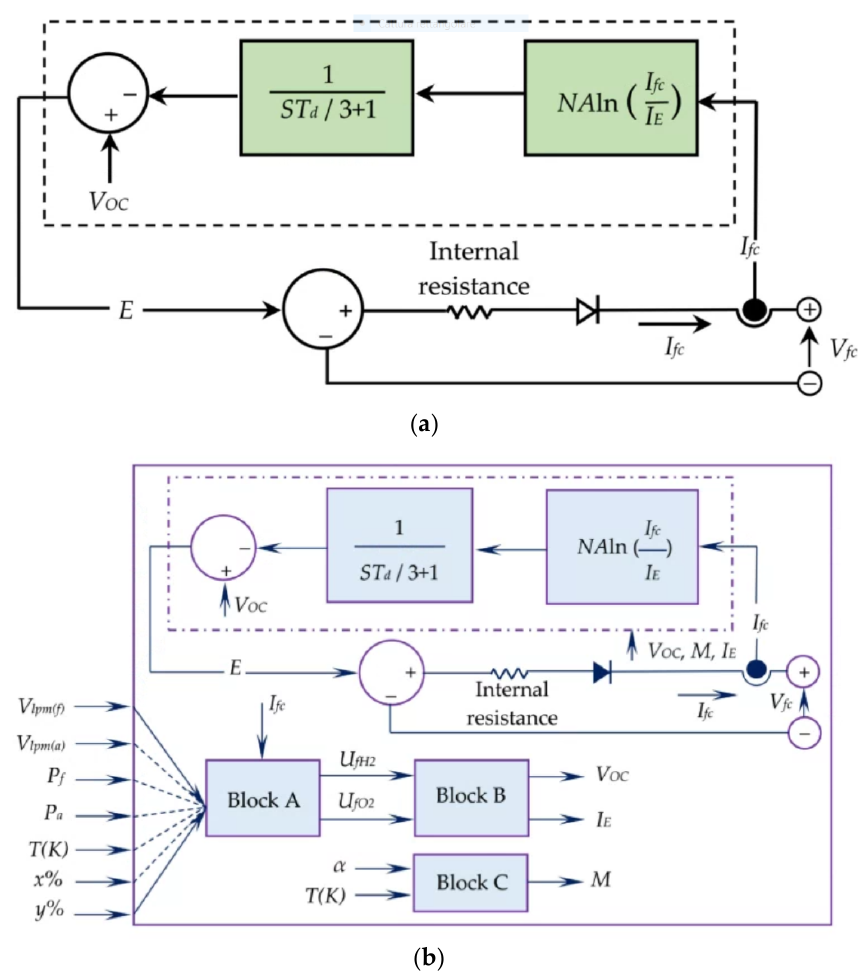
Figure 3. Equivalent circuit of the simulated PEMFC, ( a ) simplified, ( b ) detailed. Reproduced from [19] under the Creative Commons